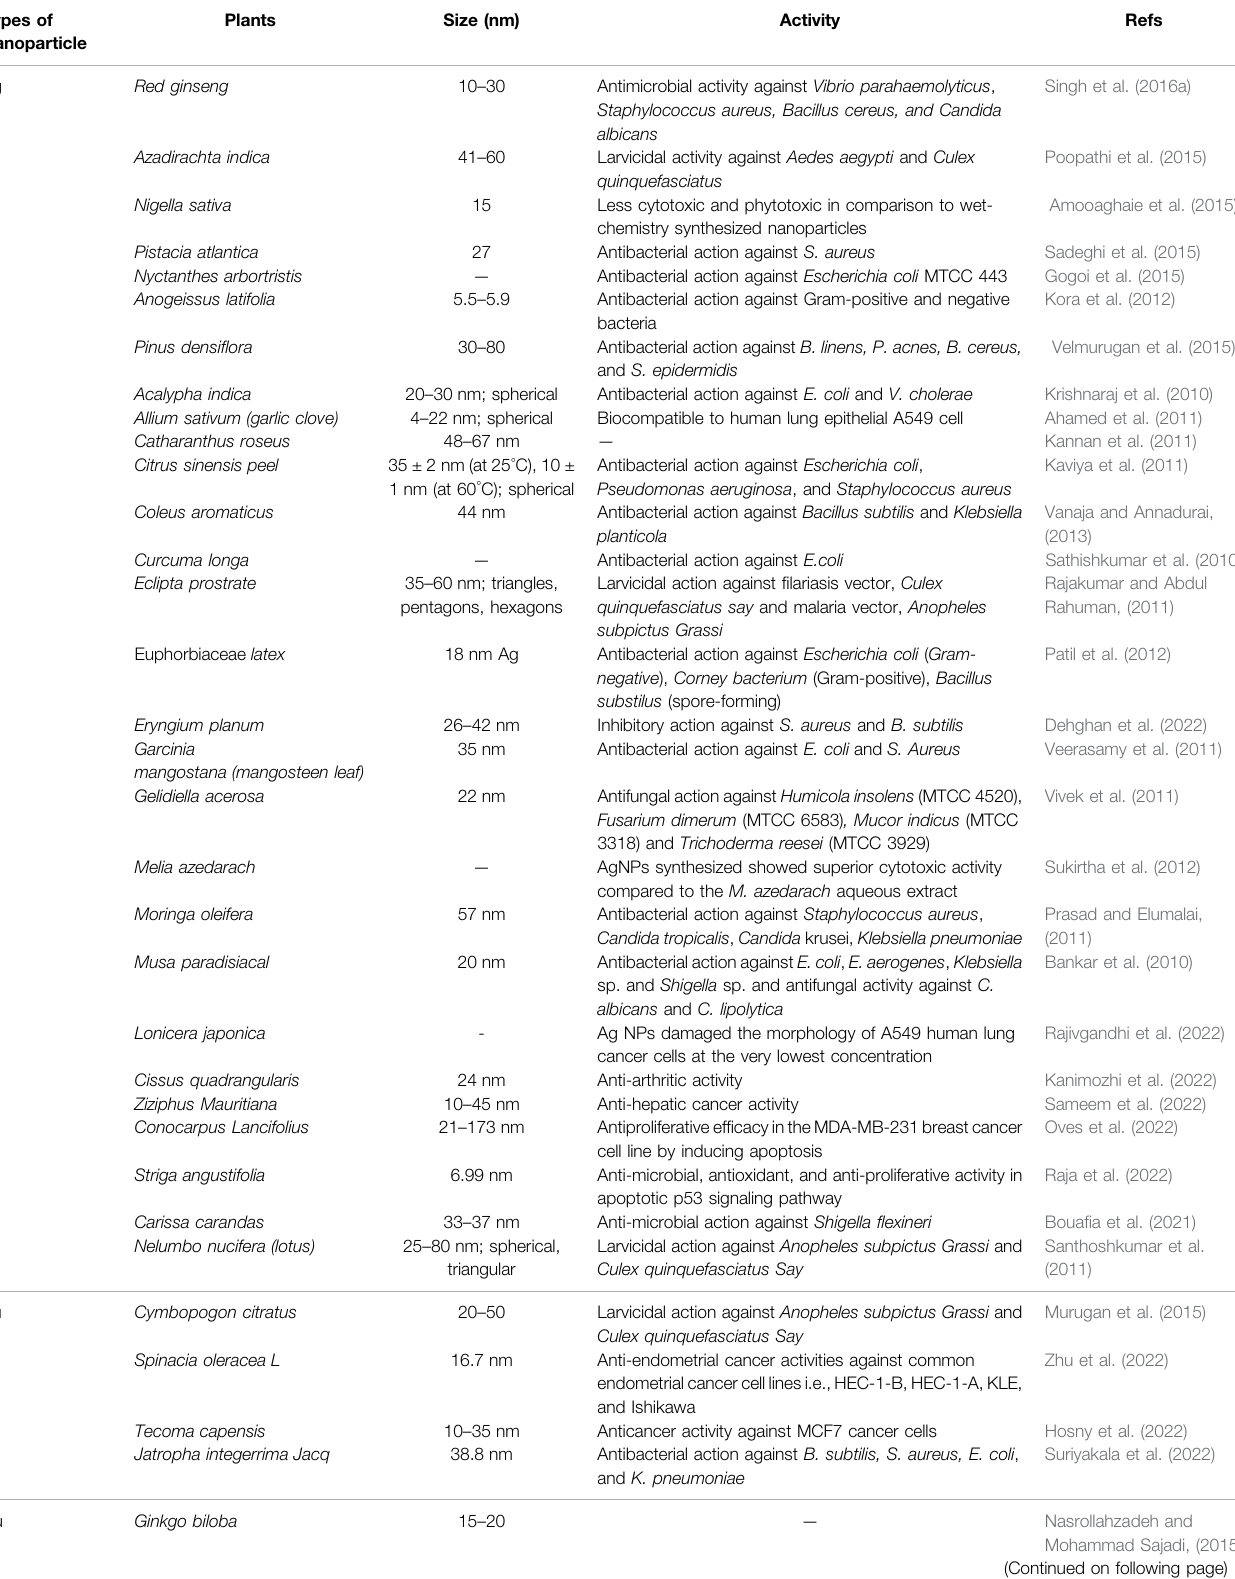
TABLE 1 | Reported data of plants responsible for nanoparticle